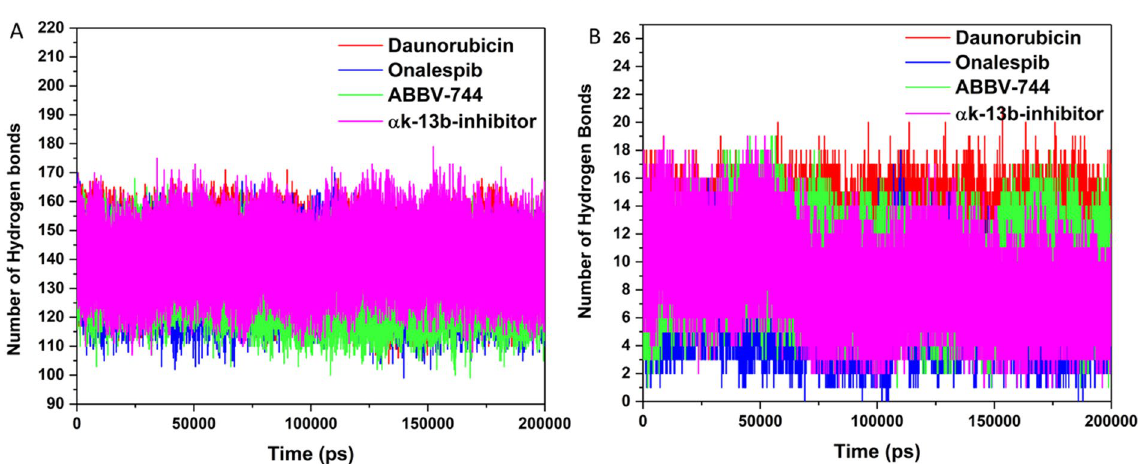
Figure 6. Hydrogen bond analysis. ( A ) Intramolecular and ( B ) Intermolecular hydrogen bonds in M pro enzyme with the selected compounds (Daunorubicin in red, Onalespib in blue, ABBV-744 in green and αk-13b inhibitor in magenta) calculated after 200 ns MD